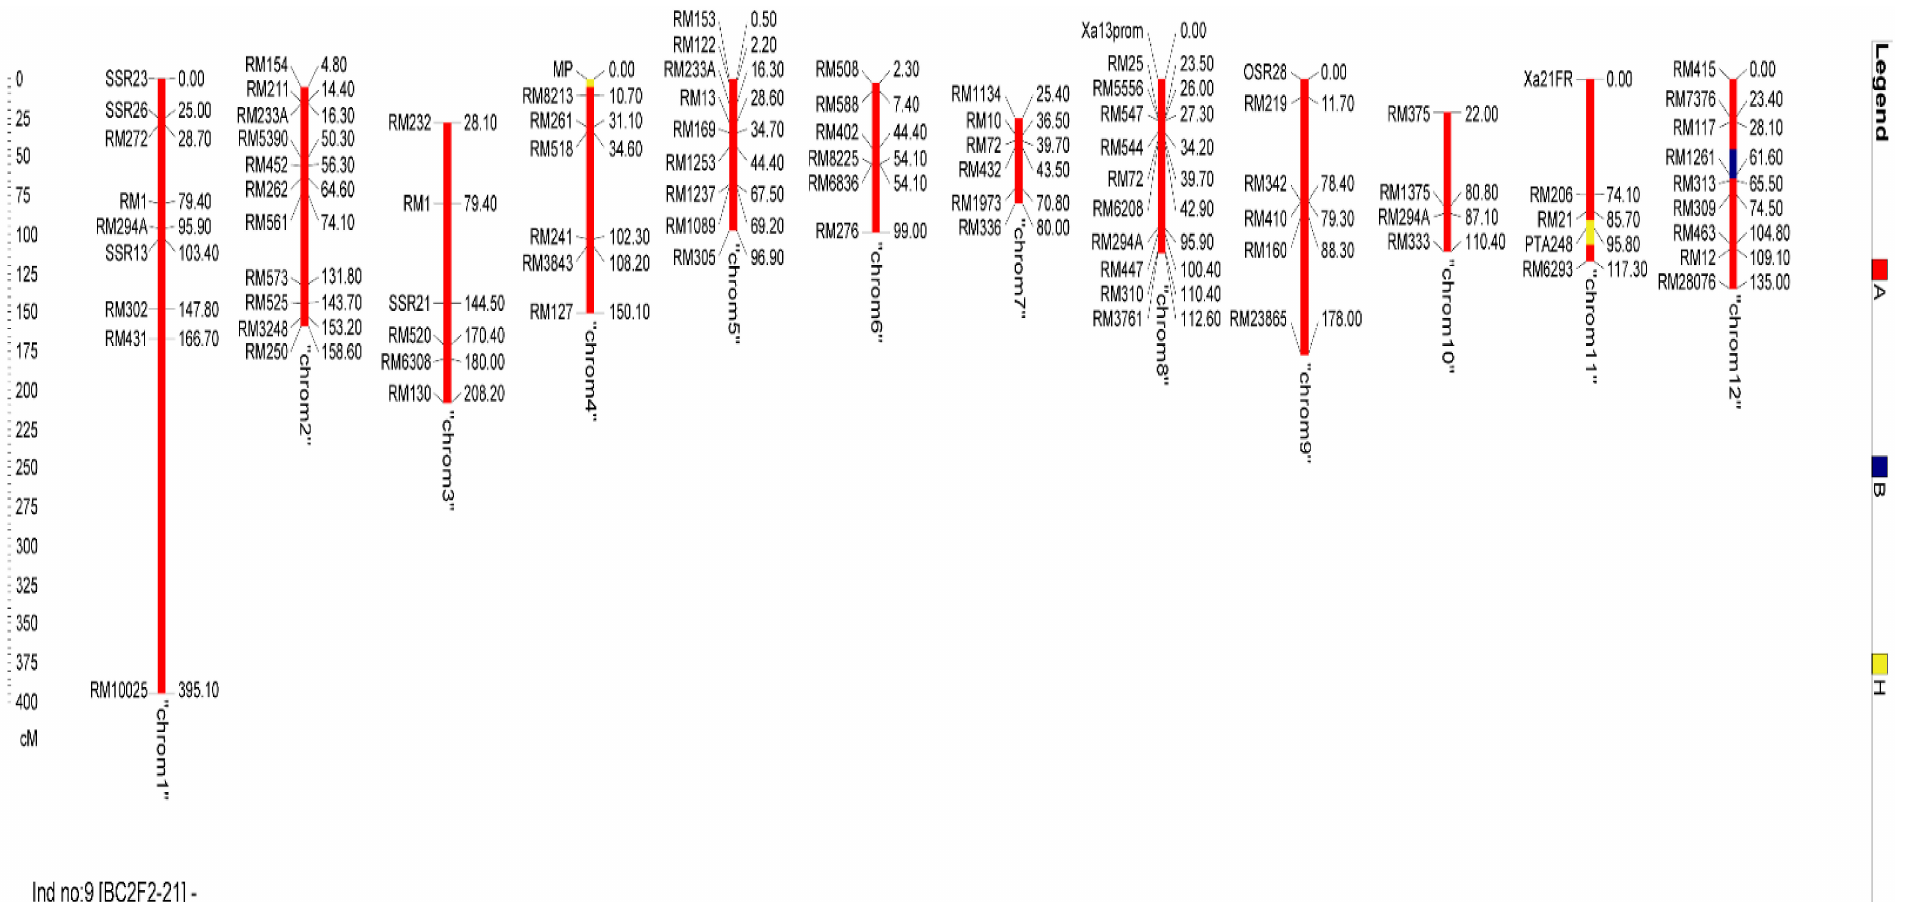
Figure 7. The best BC 2 F 2 progeny (BC 2 F 2 -21) chromosome-by-chromosome recurrent parent genome recovery (RPGR). Yellow lines denote the heterozygous region, the homozygous region for the MR297 allele is represented by the red lines, and the homozygous region for the IRBB60 allele is shown by the blue